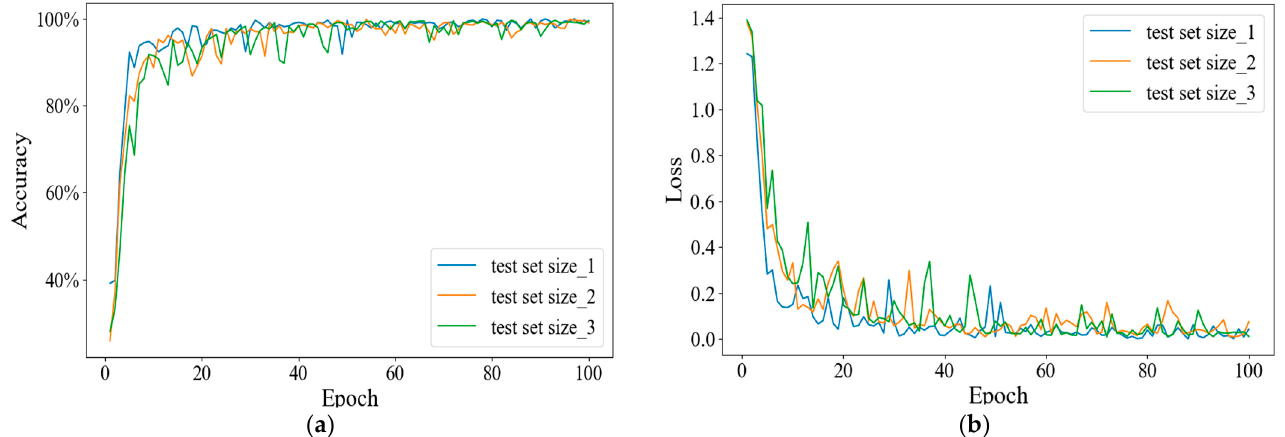
Figure 15. ( a ) Training and test accuracy curves for different proportions of divided datasets. ( b ) Training and test loss curves of different proportions of divided datasets.